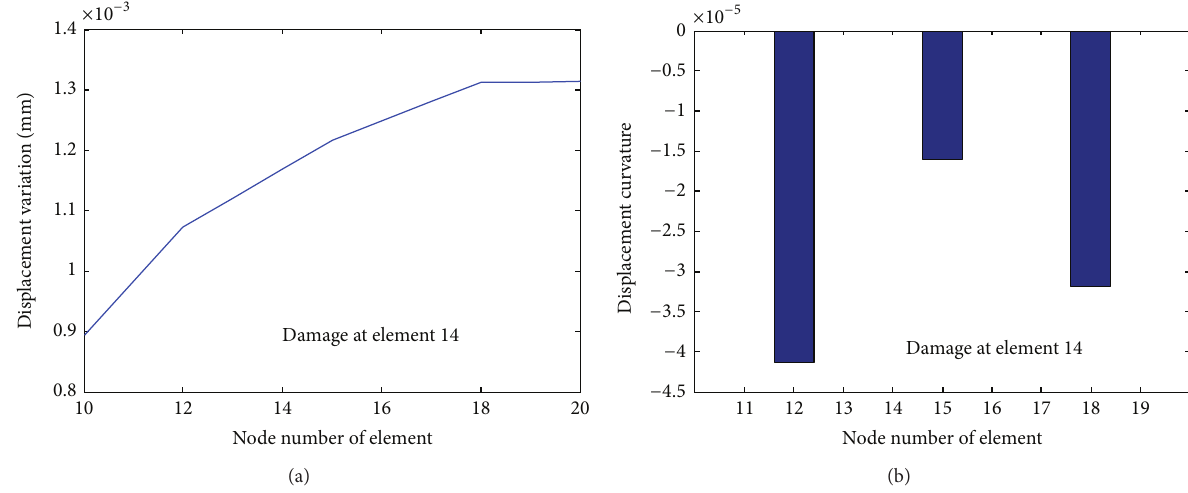
Figure 8: Damage detection of the isolated substructure (1% noise): (a) displacement variation and (b) displacement curvature.